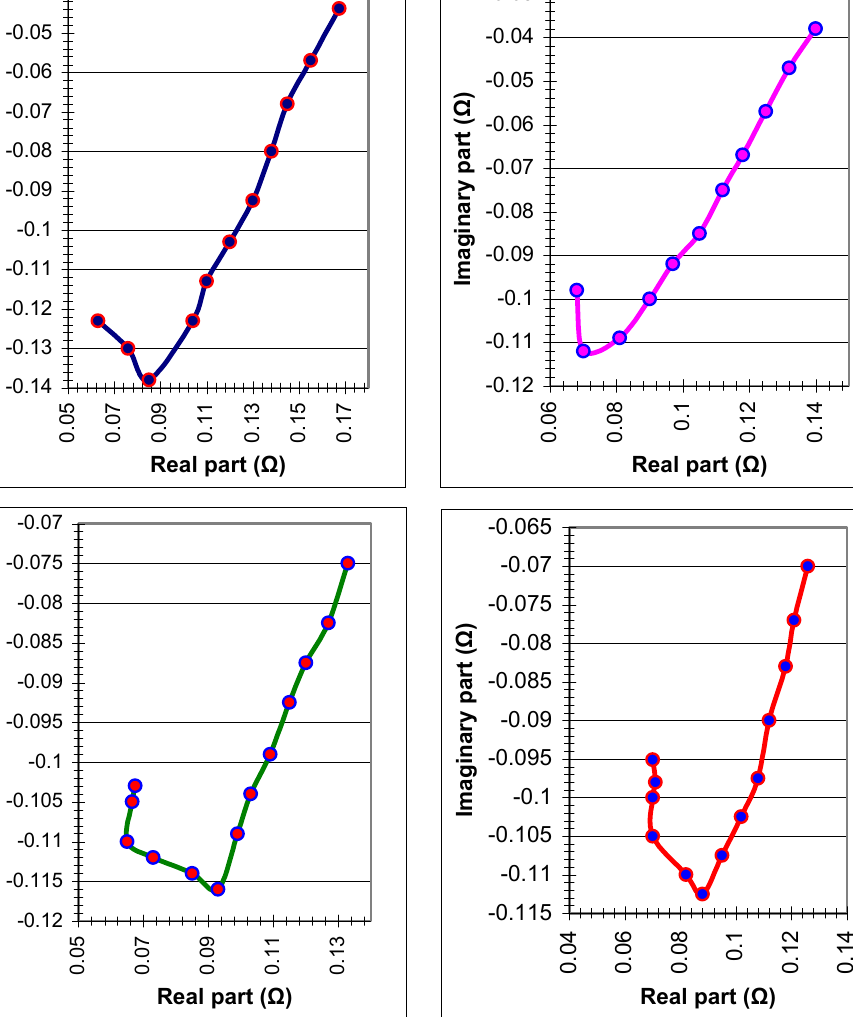
Figure 16. Impedance of the battery at an imposed current of 4A and at nominal voltage